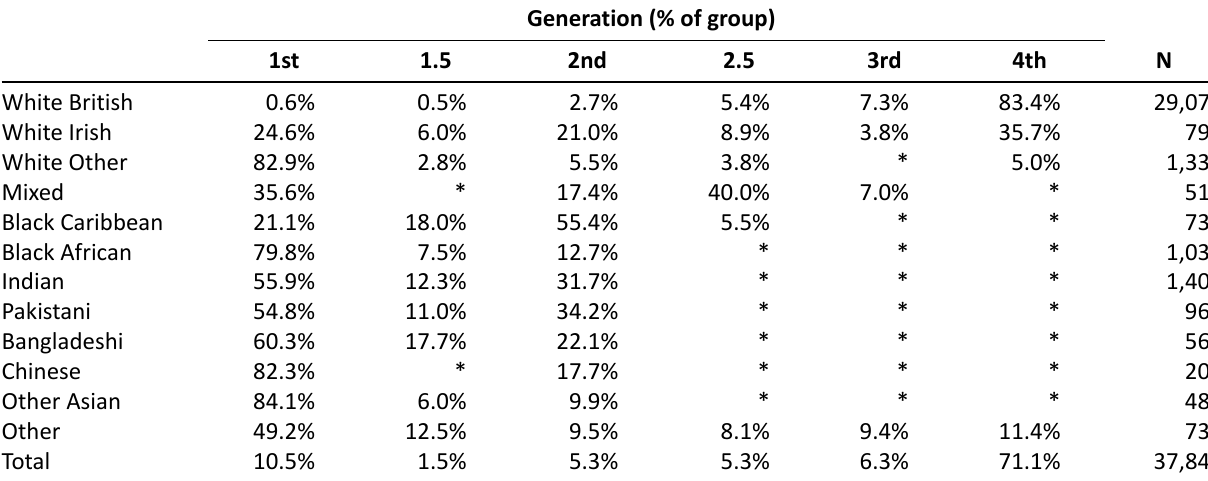
Table 1. Ethnicity by generational status in Britain, respondents aged 25–64 (2009–2012).